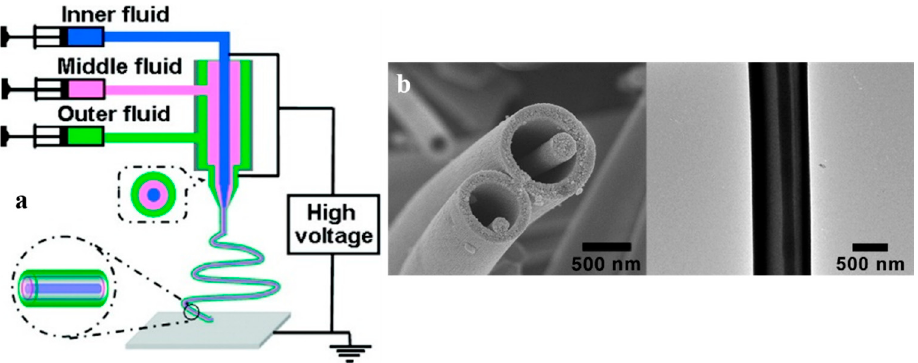
Figure 4. Triaxial electrospinning process: ( a ) triaxial spinneret; ( b ) basic mechanism (Reproduced with permission from [85]. American Chemical Society,